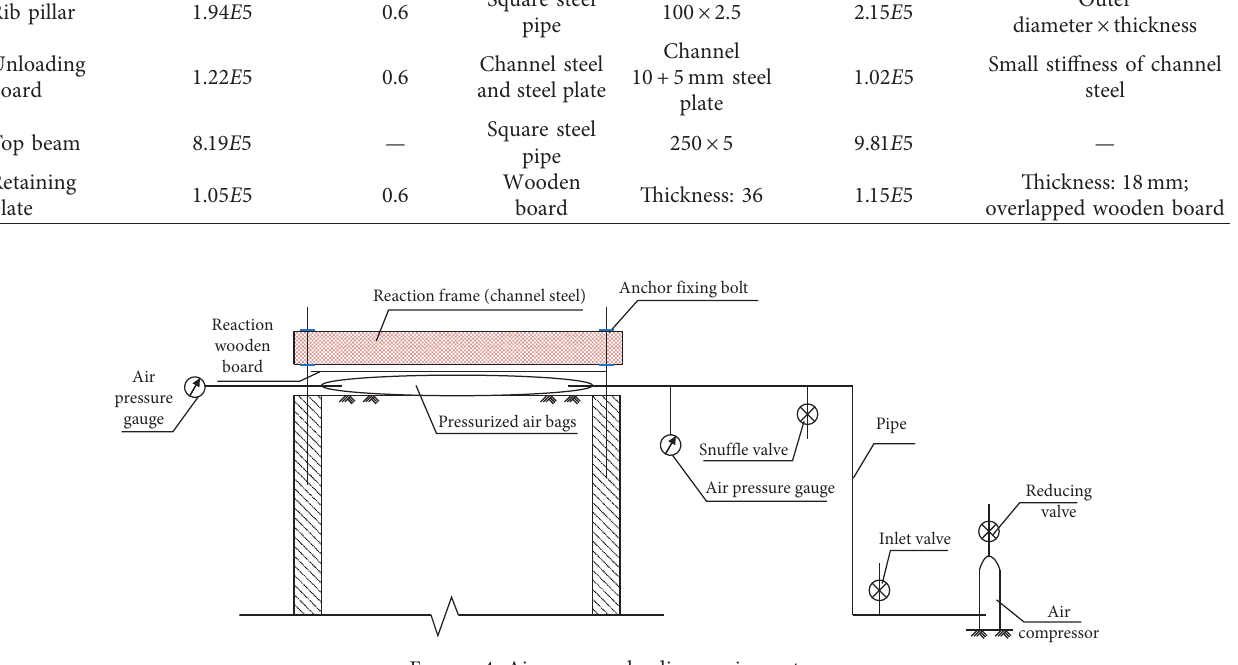
Figure 4: Air pressure loading equipment.